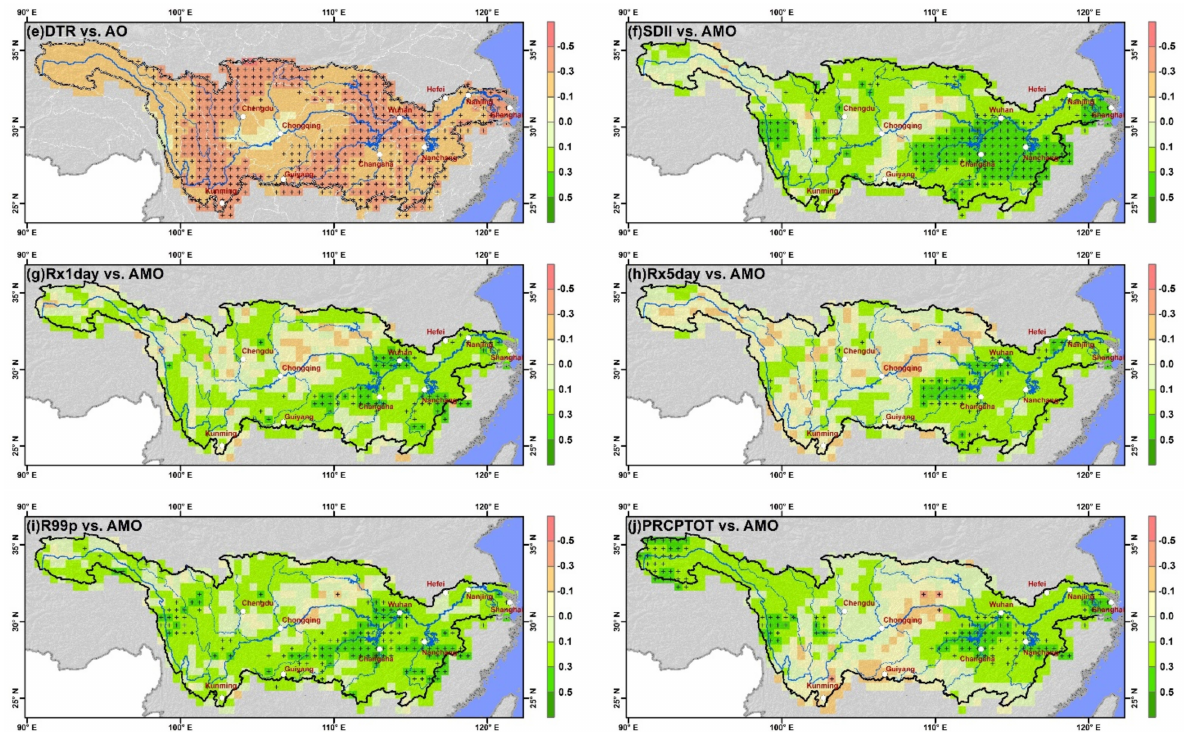
Figure 8. Spatial distribution of correlation coefficients between extreme temperature/precipitation and climate indices in the YRB during 1961 to 2020. ( a ) TXx vs. AMO; ( b ) TXn vs. AMO; ( c ) TNx vs. AMO; ( d ) TNn vs. AMO; ( e ) DTR vs. AO; ( f ) SDII vs. AMO; ( g ) Rx1day vs. AMO; ( h ) Rx5day vs. AMO; ( i ) R99p vs. AMO; ( j ) PRCPTOT vs. AMO. Significant correlation at the 0.01 significance level was indicated by